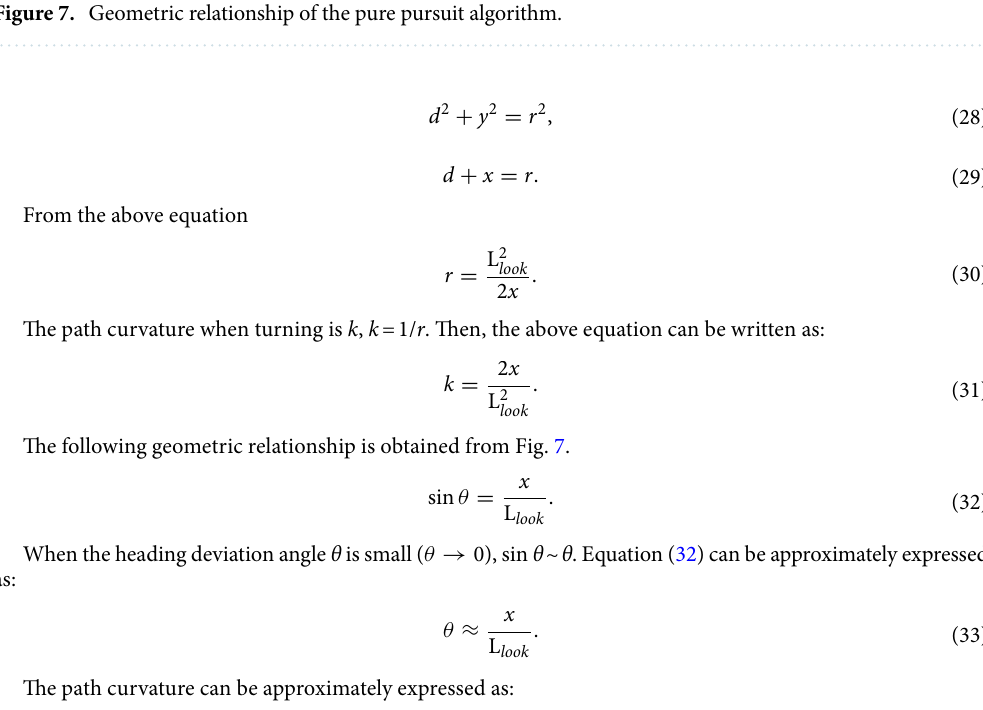
Figure 7. Geometric relationship of the pure pursuit